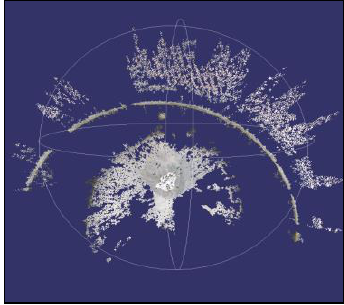
Figure 12. Tour of the photographs for the documentation of La Rebeca, nadir view.